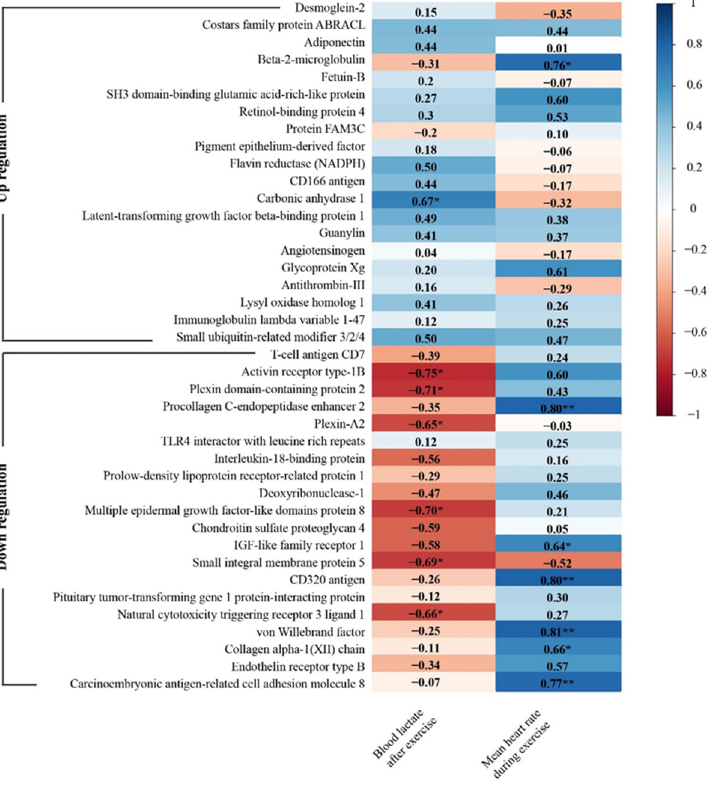
Figure 8. Correlations between the urine proteomics changes and simulated firefighting perfor- mance. * p < 0.05, ** p < 0.01 * p < 0.05, ** p <